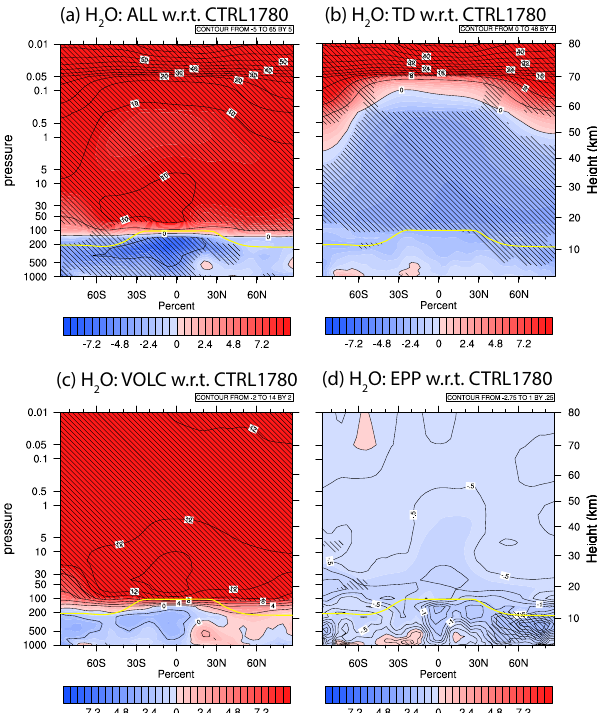
Fig. 3. Relative differences of yearly averaged water vapour of the DM-ALL, DM-TD, DM-VOLC and DM-EPP experiments with re- lation to the DM-CTRL1780 forcing run. Hatched areas are signifi- cantly different on a Student’s t test with α = 5%. The yellow line illustrates the height of the WMO